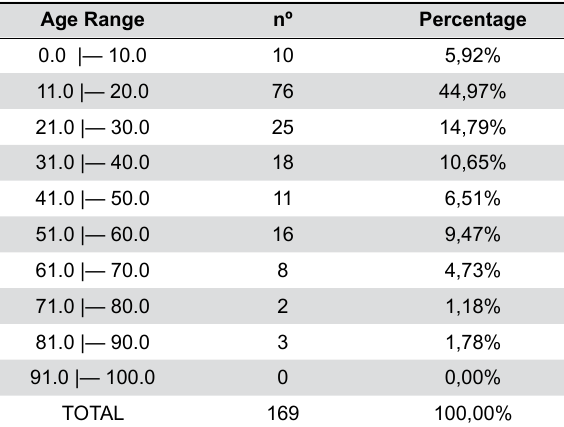
Table 4- Distribution of OTs according to age in a Brazilian Oral Pathology Age Range